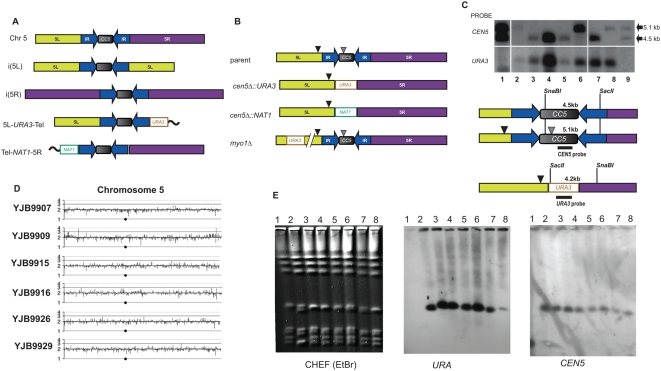
Deletion analysis of Candida albicans CEN5.A. Central core and flanking inverted repeat define the Chr5 region with centromere function. C. albicans CEN5 is composed of a central core (CC5, gray rectangle, a flanking inverted repeat (IR, blue arrows), and adjacent left (yellow, 5L) and right (purple, 5R) chromosome arms. Isochromosomes i(5L) and i(5R), derived from wild-type Chr5 (top), arose in strains YJB9891 and YJB8287, respectively. Loss rates of i(5L) are ∼10−5 loss events/division. Telomere truncation derivatives 5L-URA3-Tel (YJB9772, loss rate ∼10−3 events/division) and Tel-NAT1-5R (YJB9858, loss rate ∼10−4 events/division) were generated by deletion of the right or left arm of Chr5 within ∼0.5 kb of the inverted repeat. CC5 and the flanking IR is the only region common to these stable derivatives, indicating that centromere function resides within this region. Illustrations are not to scale. B. Replacement of CEN5. Wild-type cells carry two homologs of CEN5: the long homolog contains two LTRs (psi within CC5 and episemon to the left of CEN5 (triangles)) that are absent in the short homolog. CEN5 was replaced by URA3 or NAT1, which inserted at similar frequencies into the two CEN5 homologs. Transformation frequencies were similar for cen5Δ (∼17 transformants per µg) and the control myo1Δ or swe1Δ (∼15 tranformants per µg) insertions of URA3 on Chr5. C. Southern analysis of cen5Δ::URA3 transformants. Genomic DNA from strains carrying both wild-type CEN5 homologs (Lanes 1 and 9 (YJB8648)) and cen5Δ::URA3 strains (lanes 2–8, YJB9915, YJB9916, YJB9929, YJB9926, YJB9861, YJB9907 and YJB9909, respectively) were digested with SnaBI and SacII, separated by agarose gel electrophoresis and probed with CEN5 (upper panel) or URA3 (lower panel) DNA. Position of restriction sites, probe locations and expected sizes of restriction fragments (for both wild-type CEN5 alleles) is illustrated below. The short CEN5 homolog was disrupted in strains YJB9915, YJB9861 and YJB9909; the long CEN5 homolog was disrupted in the other cen5Δ::URA3 strains (YJB9916, YJB9926, YJB9929 and YJB9907). D. Comparative Genome Hybridization (CGH) of Chr5 in cen5Δ::URA3 strains. CGH is displayed as the copy number relative to reference control strain SC5314 using a log2 scale [28],[33]. Black dot, position of CEN5. Noncoding sequences flanking CEN5 were not present on the CGH array. E. CHEF karyotype gel analysis of all cen5Δ::URA3 strains reveals no major alterations in chromosome size in these strains. Lane1 Parental strain RM10 (YJB8648); lane2, YJB9907; lane 3, YJB9909; lane 4, YJB9915; lane 5, YJB9916; lane 6, YJB9926; lane 7, YJB9929 and lane 8, YJB9861. The blot was probed with URA3 (middle panel) or CEN5 (right panel). URA3 replaced CEN5 in the Chr5 homolog with faster mobility in YJB9907 (lane 2). Chromosome numbers are indicated at left.